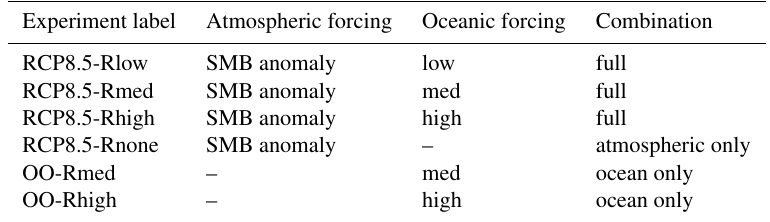
Table 2. Summary of projection experiments based on MIROC5 RCP 8.5 climate